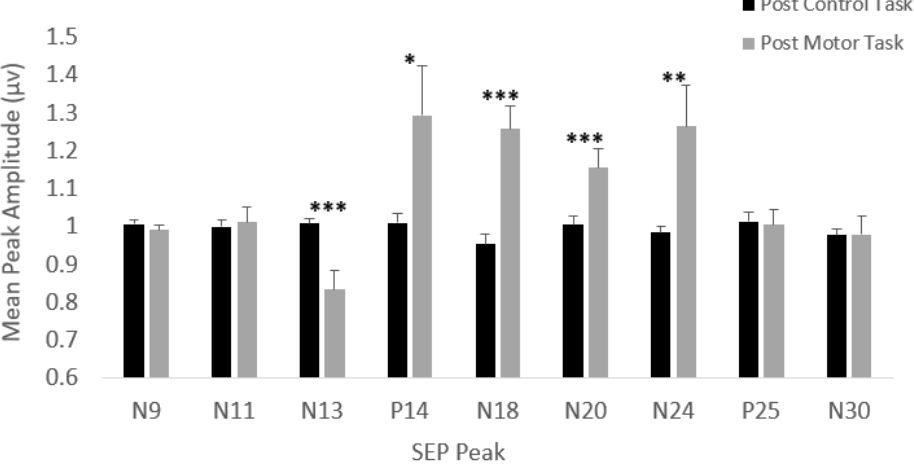
Figure 4. Normalized mean percent amplitude change following control task and motor training task, +SE. Note the significant change in post-motor task amplitude for the N13, P14, N18, N20, and N24 peaks. * p < 0.05, ** p < 0.01, *** p < 0.001, with respect to baseline. Normalized baseline somatosensory evoked potential (SEP) amplitudes are equal to one.